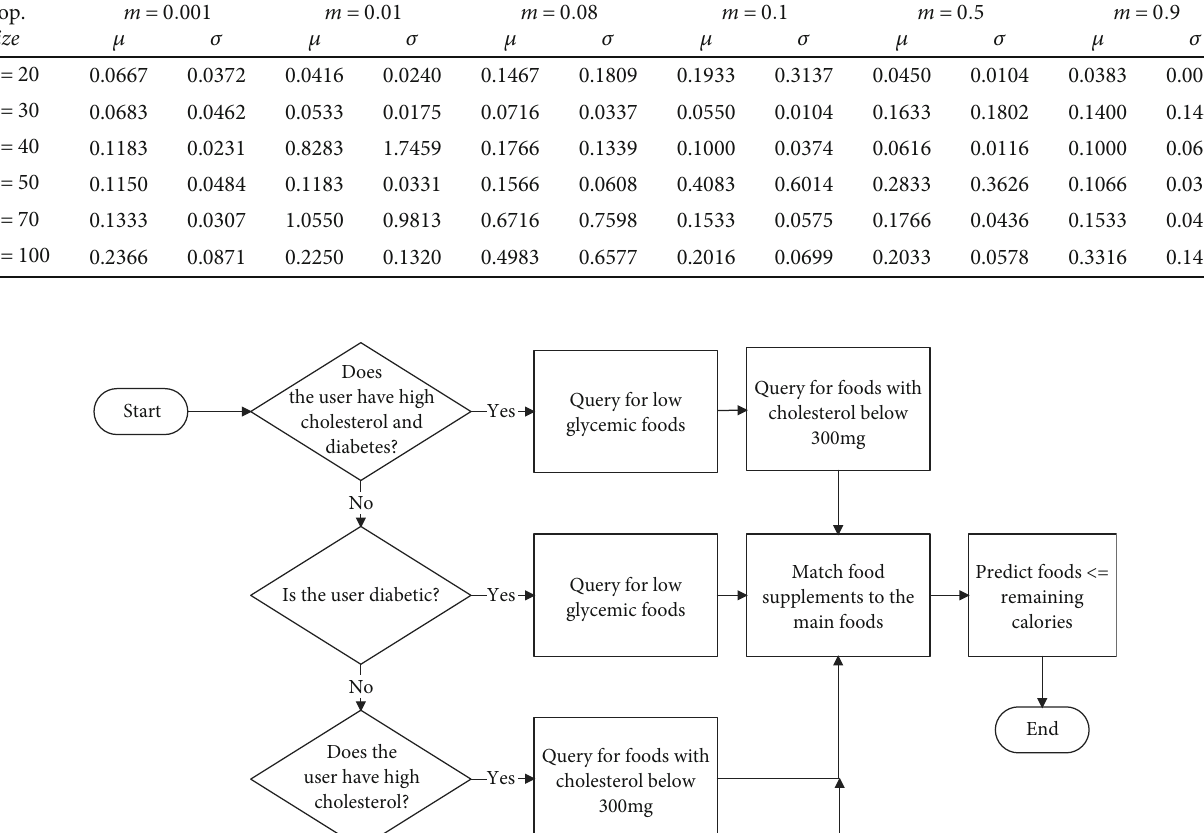
Table 6: Average convergence time and deviation for simulations in seconds.